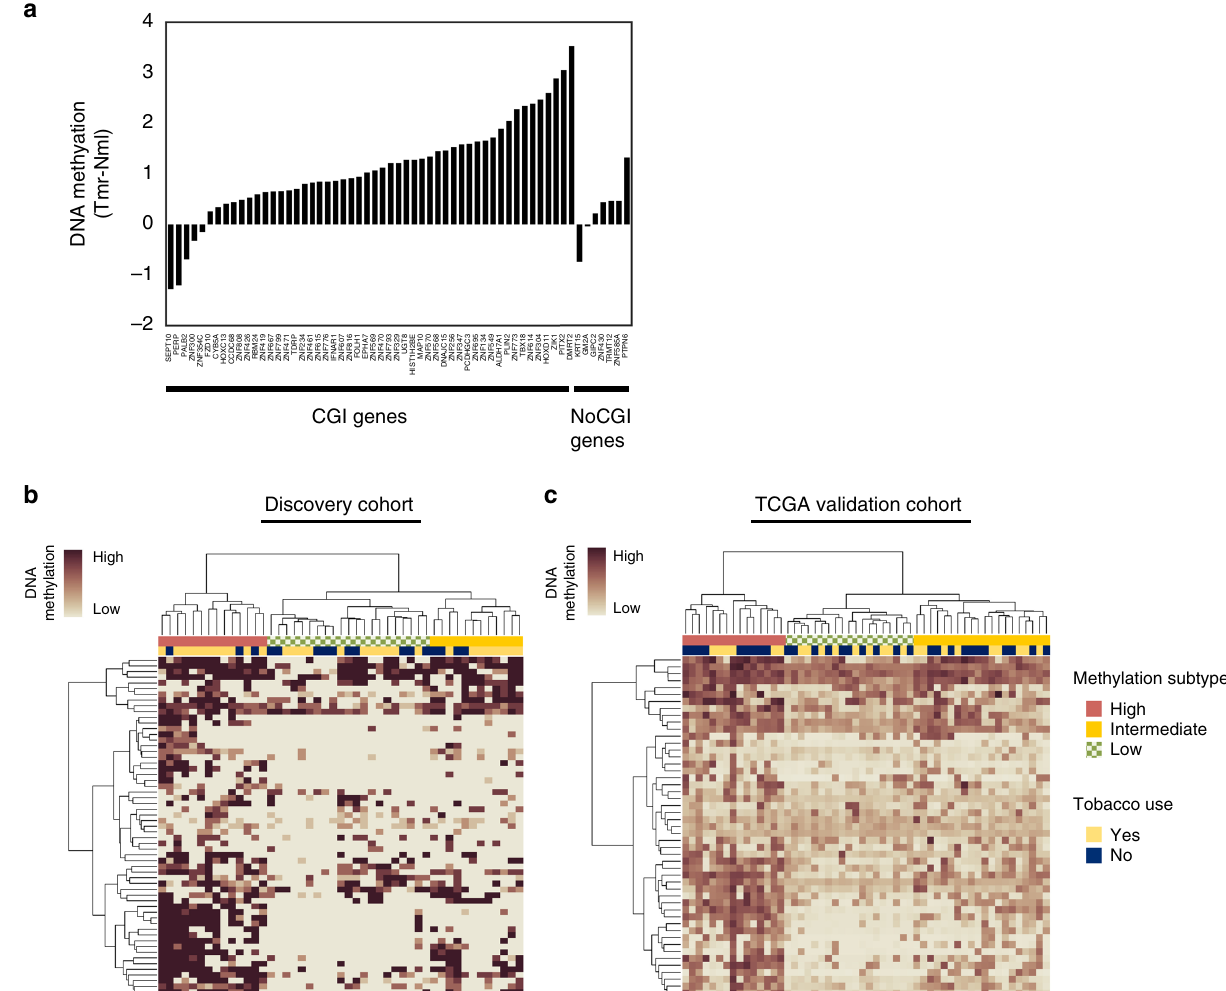
Fig. 3 Unsupervised hierarchical clustering based on DNA methylation-expression correlations. a Changes in DNA methylation levels of 59 genes for the discovery cohort. b , c Clustered heatmaps for methylation levels of the genes (rows) and HPVOPSCC tumor samples (columns). Identical gene set was used for the discovery cohort ( b , n = 47) and the TCGA validation cohort ( c , n =